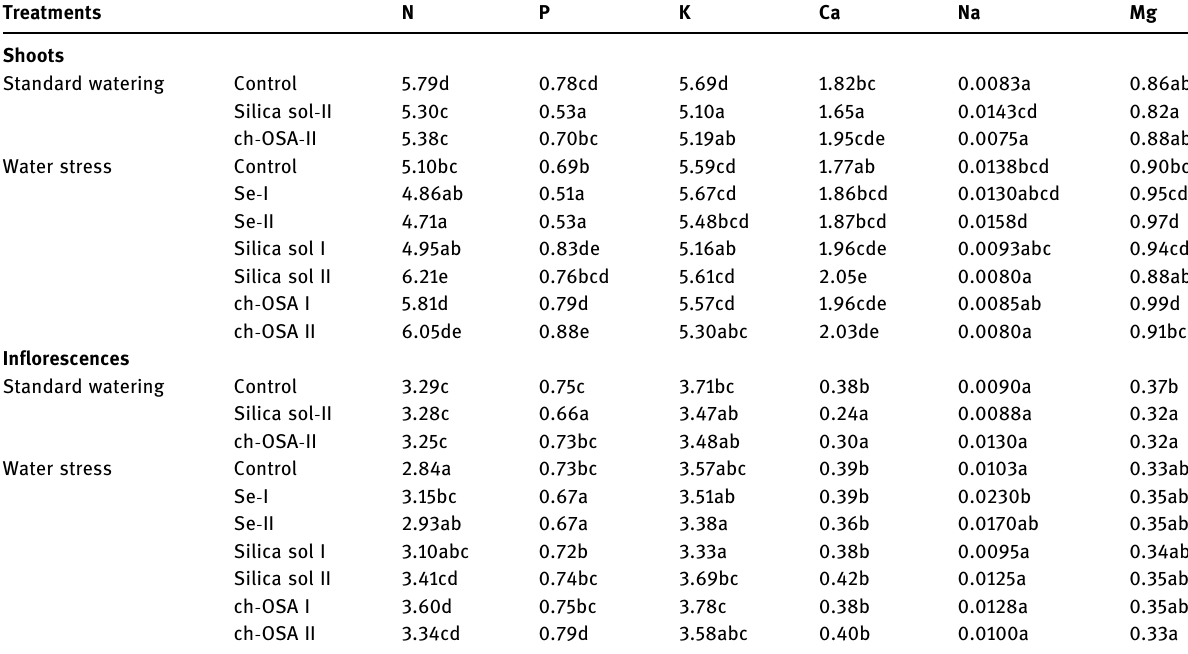
Table 4: The in fl uence of the factors under study on the content of macroelement and sodium in shoots and in fl orescences of Tagetes patula L. “ Pascal ” ( in % of D.M. ) Treatments Shoots Standard watering